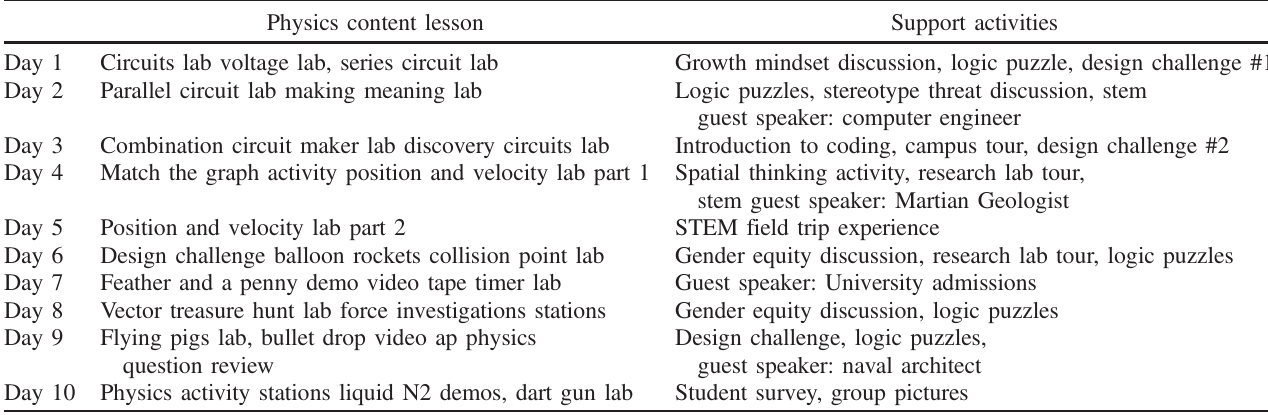
TABLE I. Sample schedule of